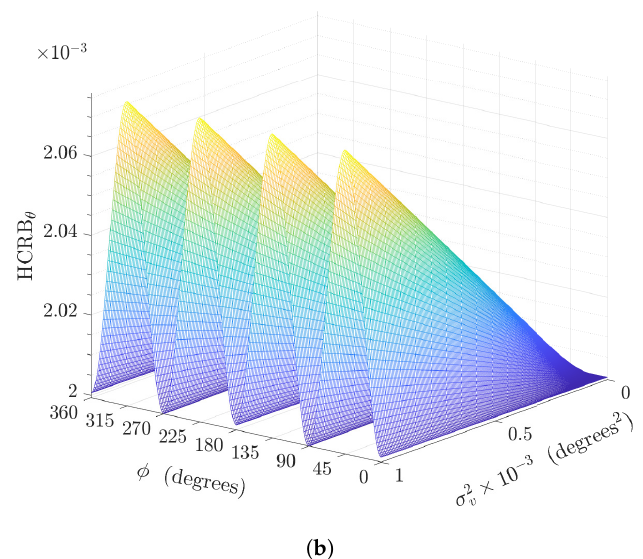
Figure 3. Plot of HCRB θ versus the directions-of-arrival for the azimuth angles and ( a ) polar angle θ ∈ [ 0,90 ◦ ] ( σ v = 0.0873 radian), and ( b ) skew angle variance σ 2 samples, σ 2 s / σ 2 n = 5.